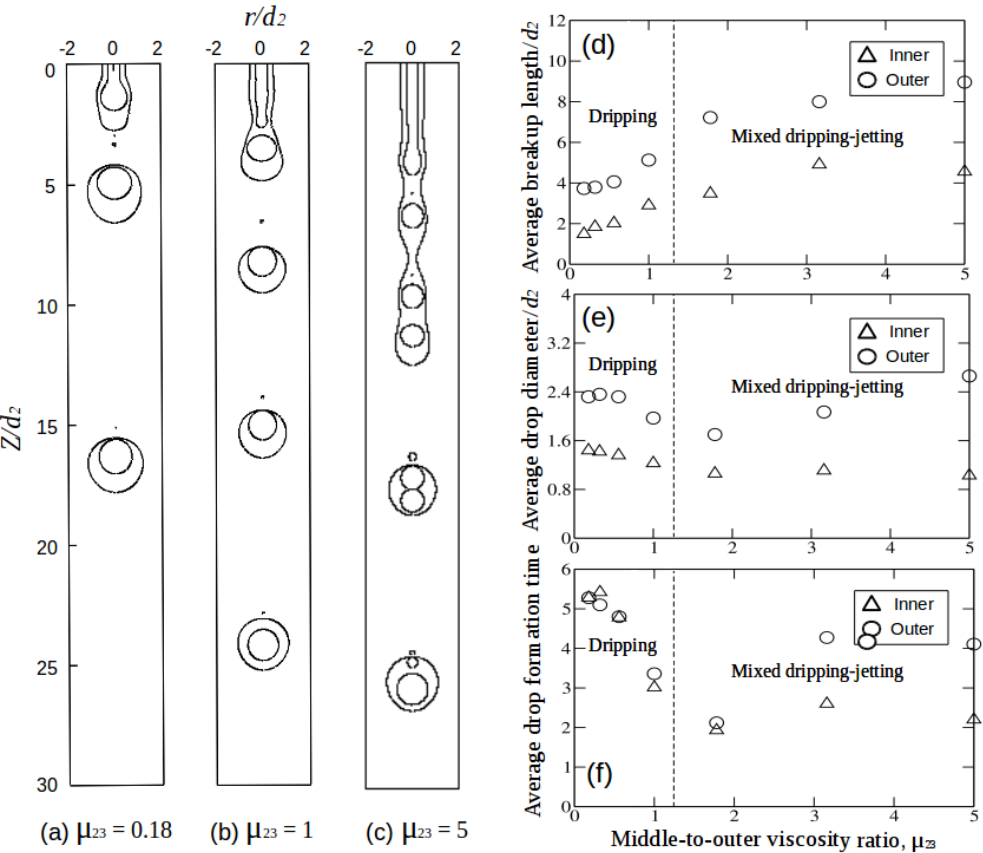
Figure 11. Snapshots of compound liquid jets for ( a ) µ 23 = 0.18; ( b ) µ 23 = 1 and ( c ) µ 23 = 5. The rest of the parameters are ρ 13 = 1, ρ 23 = 1 and µ 13 = 1. Graphs ( d – f ) represents the average breakup length, drop diameter and drop formation time for variable intermediate-to-outer viscosity ratios.